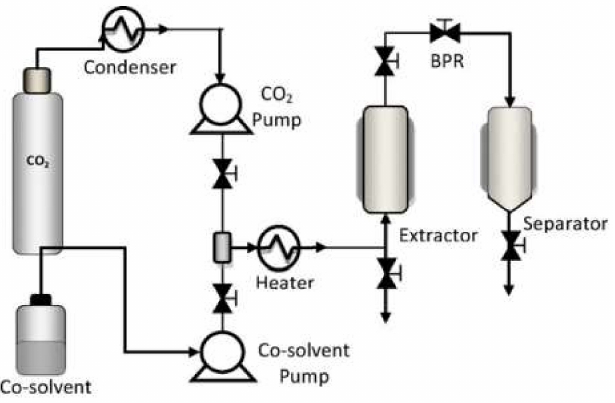
Figure 1. Flow diagram of the supercritical extraction and impregnation